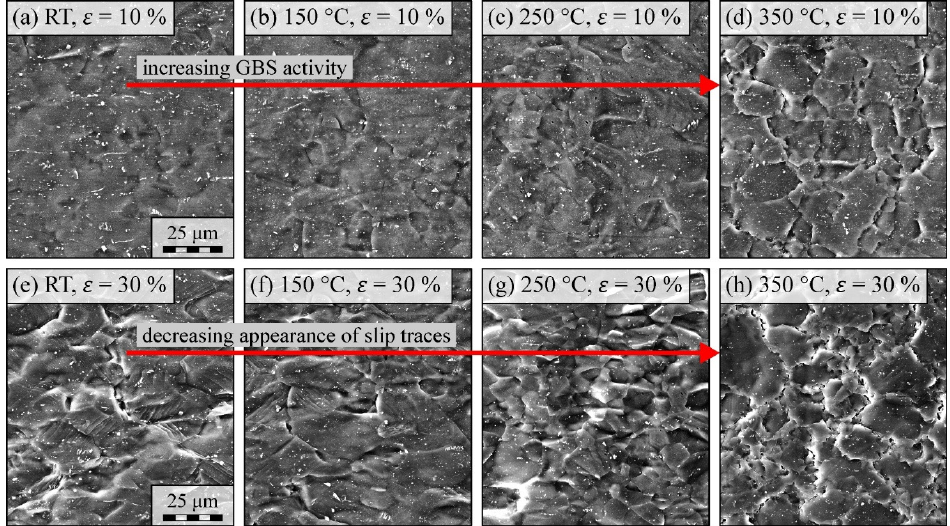
Figure 6. Increasing grain boundary sliding (GBS) activity observed for simple tension specimens at ( a ) RT, ( b ) 150 °C, ( c ) 250 °C, and ( d ) 350 °C, and strains equal to 10%; varying slip trace appearance ( b ) 150 ◦ C, ( c ) 250 ◦ C, and ( d ) 350 ◦ C, and strains equal to 10%; varying slip trace appearance observed for observed for simple tension specimens at ( e ) RT, ( f ) 150 °C, ( g ) 250 °C, and ( h ) 350 °C, and strains equal to 30%.